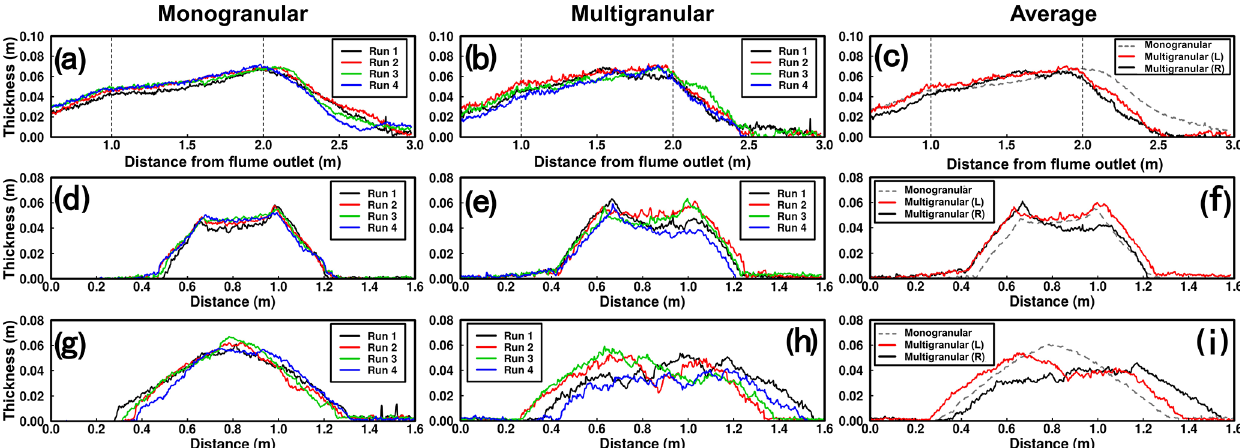
Figure 15. Profiles of the final fans. The left, center, and right panels indicate monogranular flows, multigranular flows, and their averages, respectively. (a–c) Longitudinal profiles at the center of the fan. Vertical broken lines indicate the boundaries of bed slope (i.e., the change points from 12 to 9 ◦ and from 9 to 6 ◦ ). (d–f) Cross section (transverse profile) located 1m downstream from the flume outlet. (g–i) Cross section (transverse profile) located 2.2m downstream from the flume outlet. In panels (d) – (i) , the x axis indicates the distance from the left-bank side of the cross sections (the fan was centered at approximately 0.8m). In panels (c) , (f) , and (i) , the broken gray line indicates the average value of all monogranular flows. The red and black lines indicate the average values of the flows that produced fans that were elongated on the left-bank side (i.e., test runs 2 and 3) and on the right-bank side (test runs 1 and 4), respectively.